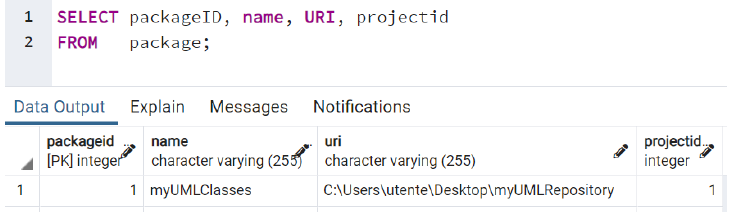
Figure A3. Query 2.